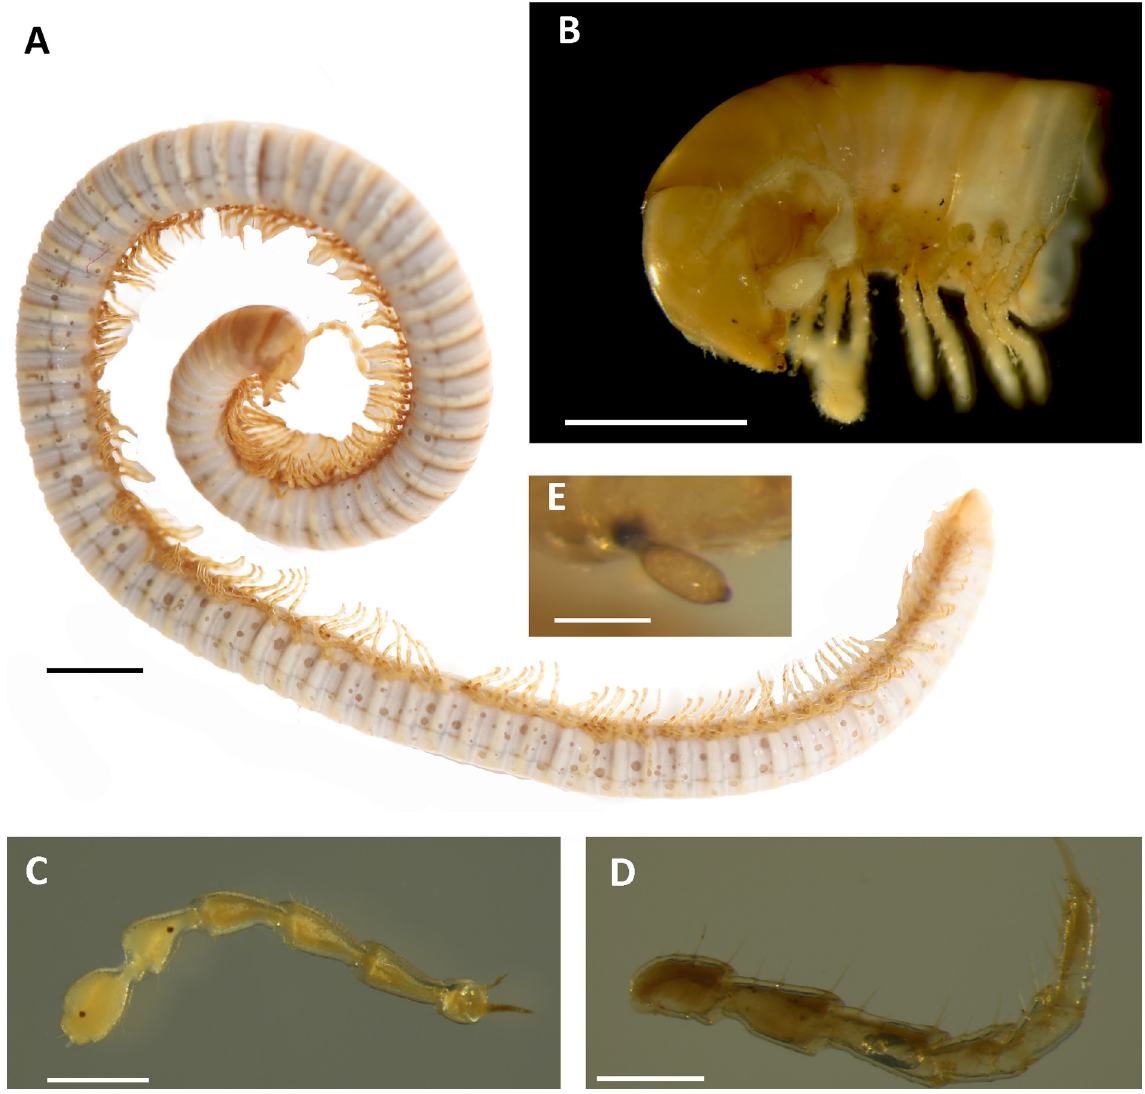
Fig. 1. Odontostreptus fadriquei sp. nov. A, C . ♀, paratype (MZB 2019-2016). B, D–E . Holotype, ♂ (MZB 2003-1301). A . Habitus. B . Head and rings 1–6. C . Antenna. D . Midbody leg. E . “Amphoromorph” fungus from leg. Scale bars: A = 2 mm; B = 1 mm; C = 0.5 mm; D = 0.25 mm; E = 0.05